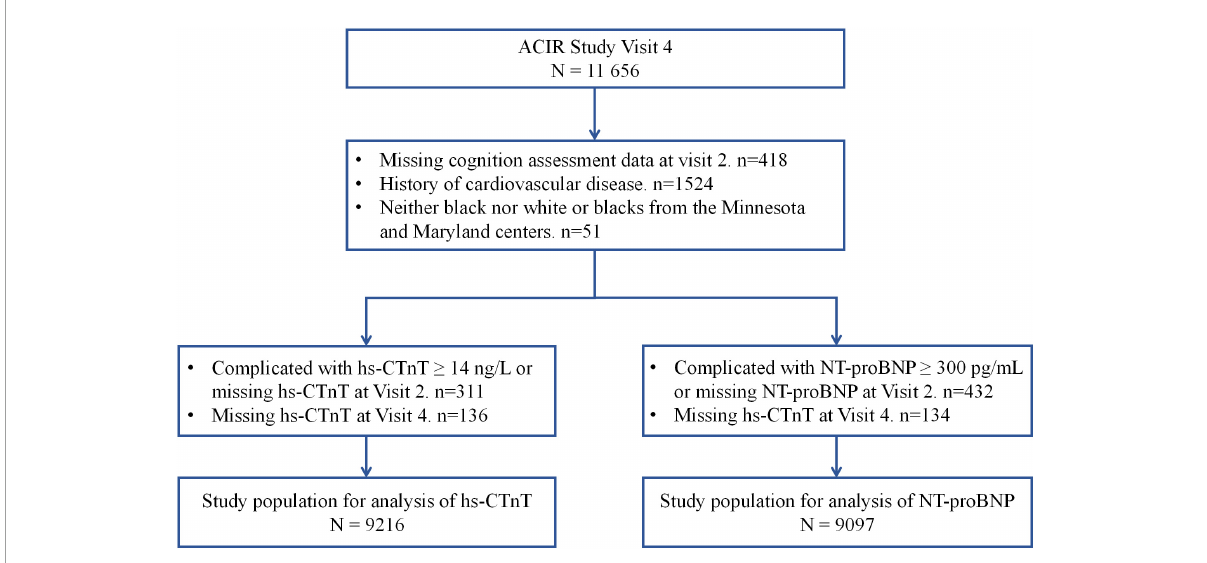
FIGURE1 Study flow chart. hs-CTnT, high-sensitive cardiac troponin T; NT-proBNP, N-terminal pro-B-type natriuretic peptide.